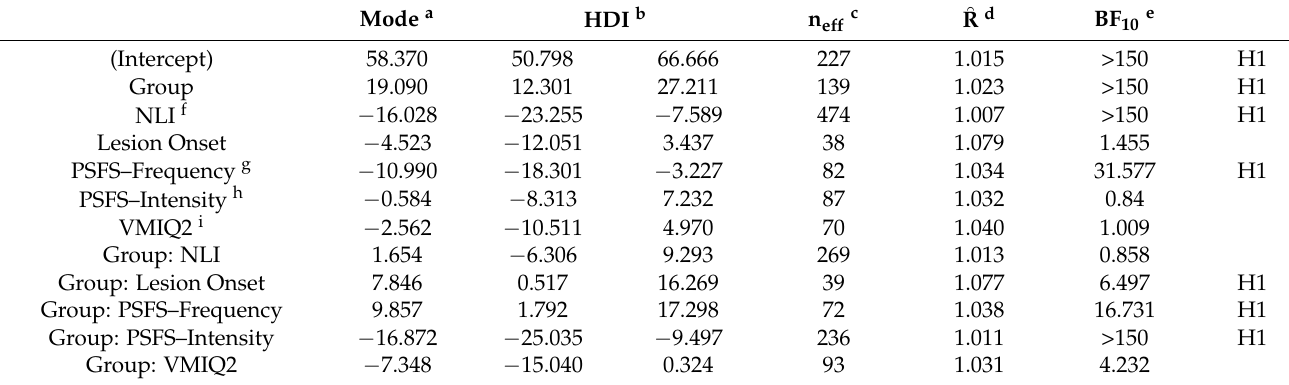
Table 5. Results from the Bayesian model referring to the BSE evaluations with the FOOT background trials at T1, co-varying with NLI, PSFS and VMIQ-2. Description as in Table 2.